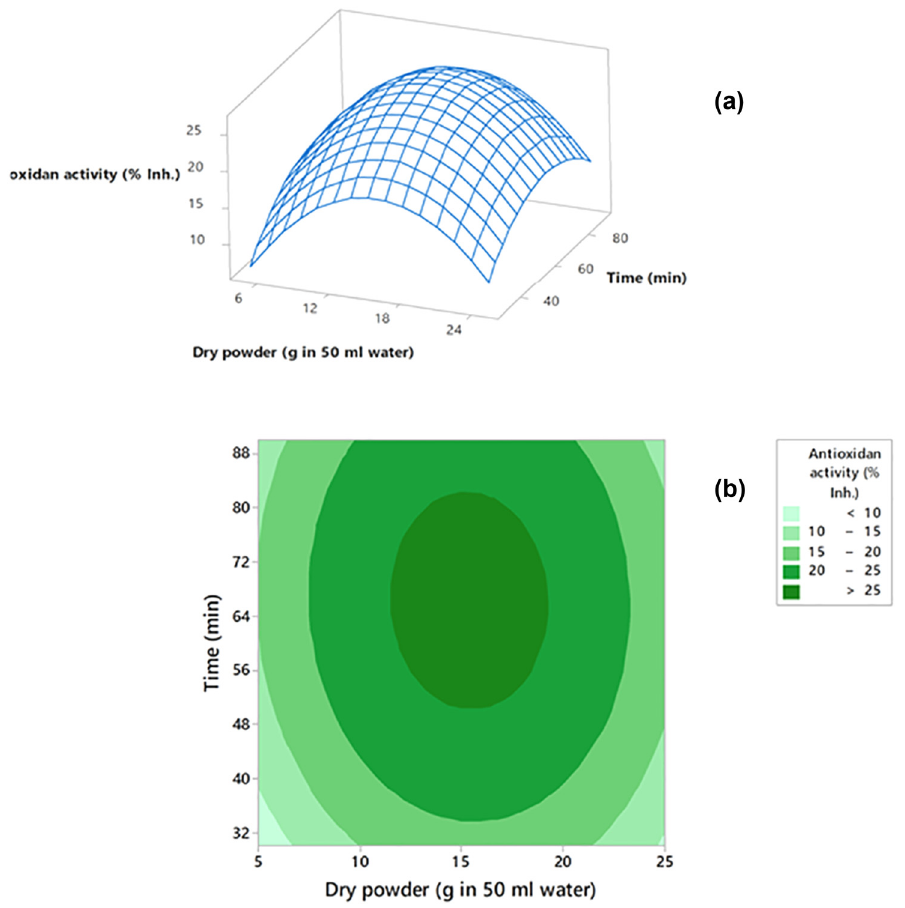
Figure 7: Response surface ( a ) and contour plots ( b ) for the antioxidant activity of the produced ZnO